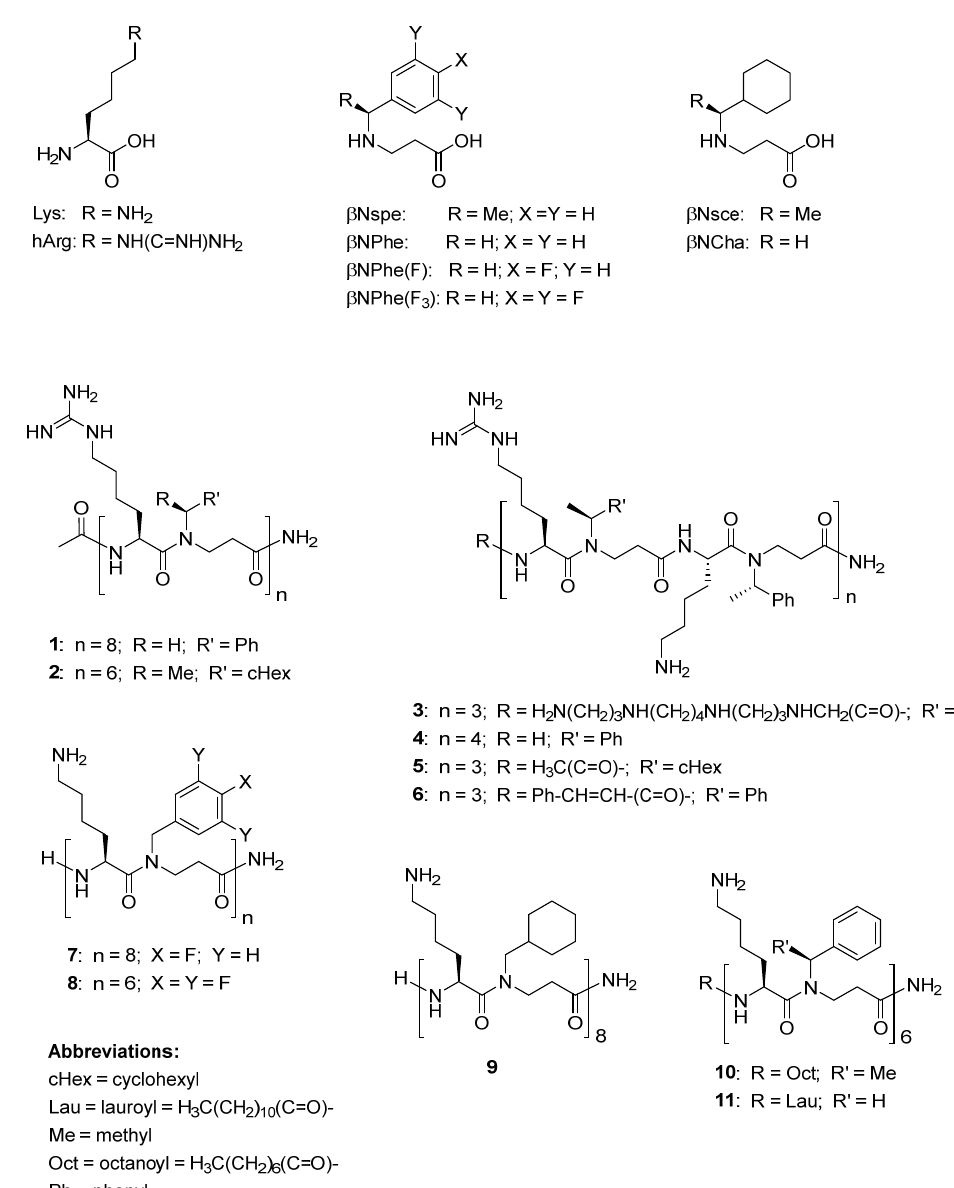
Figure 1. Chemical structures of compounds investigated in the present study.